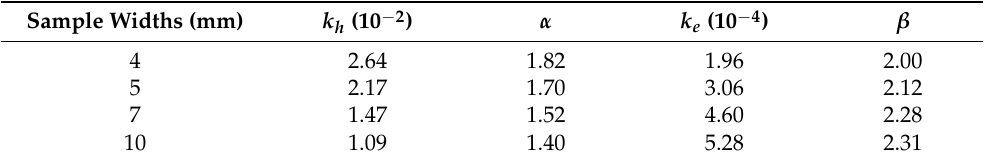
Figure 6. Approximations of the coefficient ( a ) c h ; ( b ) c e . calculated for the range of 200–500 Hz for samples with a width of 10 mm cut with a guillotine for the induction range from 0.4 to 1.2 T (red dotted line—approximation). Table 1. Coefficients k h , k e , α , and β approximating the specific loss characteristics of electrical steel sheets M270-35A as a function of the width of the sample cut with a guillotine for the frequency range 5–50 Hz and the induction range up to 0.6